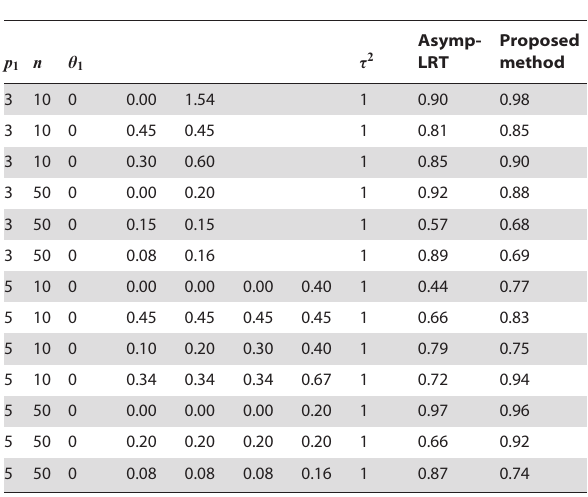
Table 6. Power for log-normally distributed